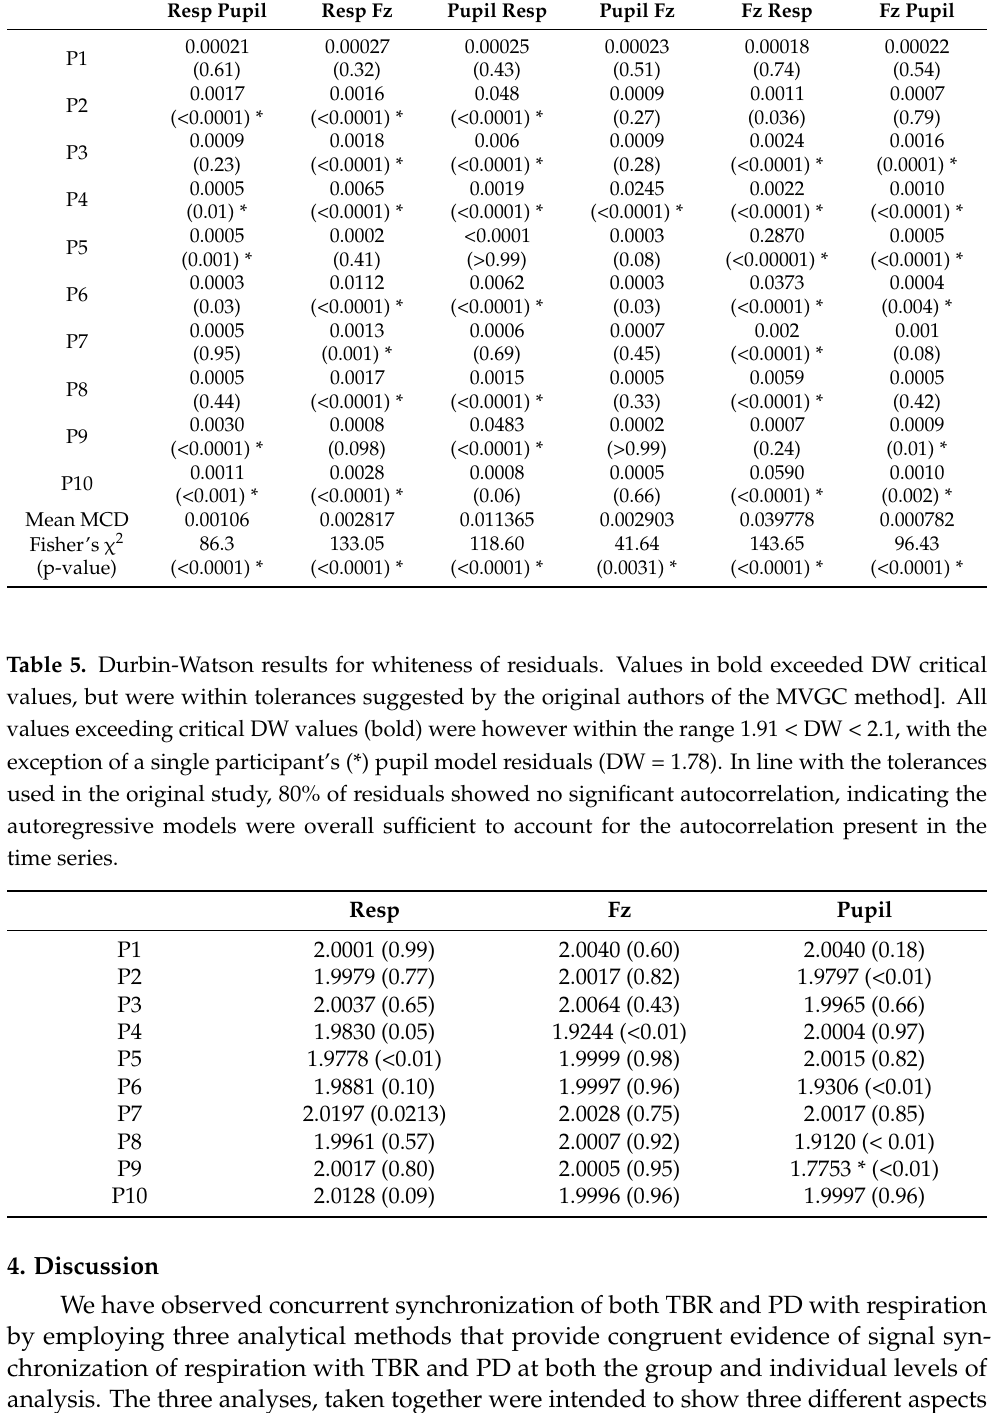
Table 4. Summary of MVGC analysis. Each cell contains the MCD (above) and associated p -value (below in parentheses). For participant and mean MCDs, an asterisk (*) indicates significance after Bonferroni correction for multiple tests. Mean MCD was also calculated across participants for each granger-causal paired relationship, indicating the general relative magnitude of the causality. The bottom row shows Fisher’s χ 2 and corresponding p -value for the null hypothesis of zero information transfer occurring across the group, as a whole, compared against adjusted α = 0.016.